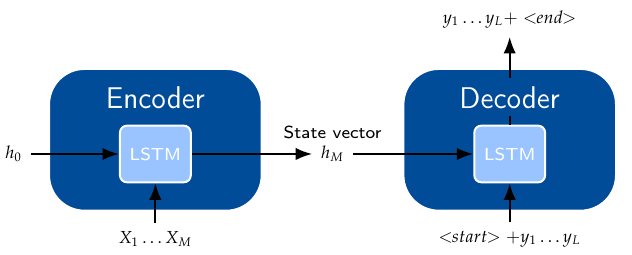
Figure 8. A simple encoder–decoder model for time series. See text for